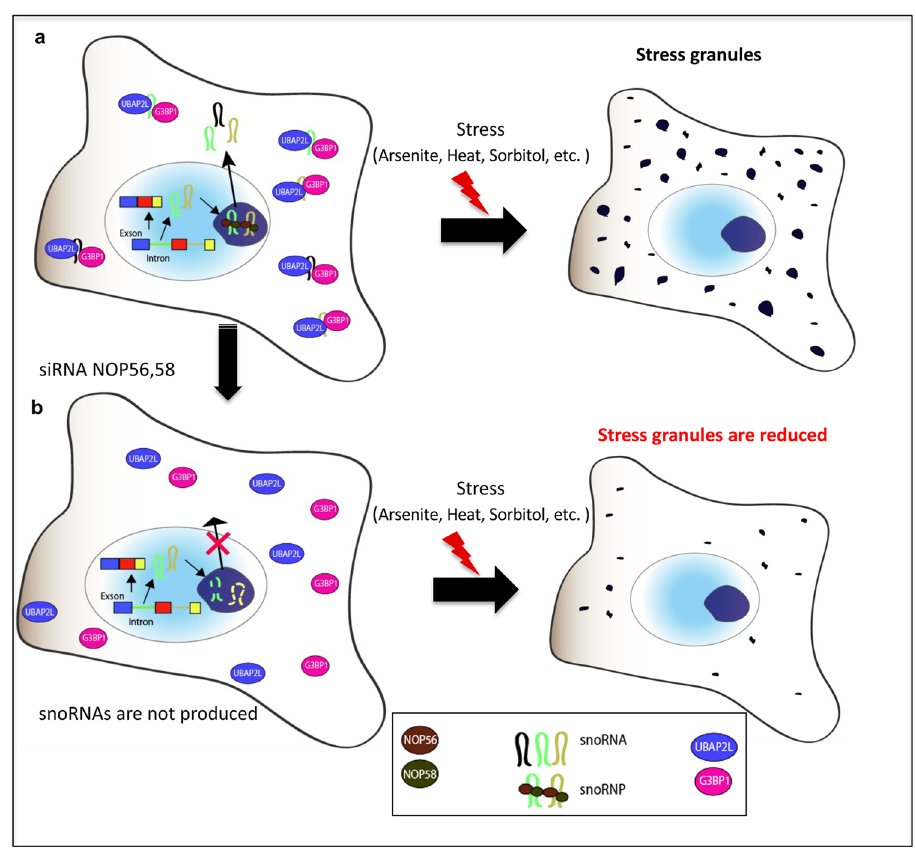
Fig. 7 A schematic model of the UBAP2L-snoRNA complex in SG. a In the nucleus, snoRNAs are produced by introns and complex with NOP56 and NOP58 as snoRNPs and matured by endonucleases. Some snoRNAs are produced in the cytoplasm. UBAP2L and G3BP1 complex with C/D box snoRNAs in the cytoplasm. Once cells are stimulated by stress, SGs are formed normally. The cells can adjust to the stress conditions to survive. b When the expression of C/D box snoRNAs is reduced by NOP56 or NOP58 depletion, UBAP2L and G3BP1 cannot form a complex. The number of SGs is reduced, and it is dif fi cult for the cell to adjust to